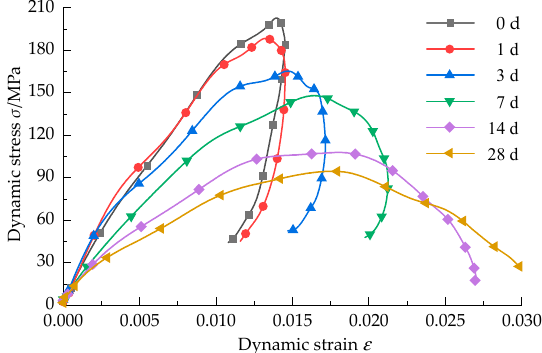
Figure 5. Dynamic stress–strain curves of sandstone at different corrosion times.